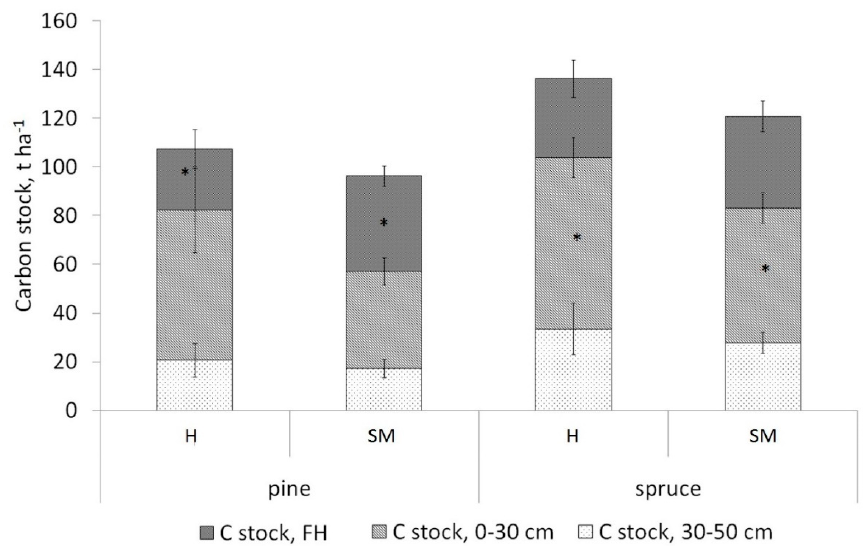
Figure 9. Soil carbon stocks in forests on Carbic Albic Podzols and Albic Retisols with a high proportion of herbaceous plants—H ( n = 12 in pine forests, n = 12 in spruce forests) and with dwarf shrubs and green mosses—SM ( n = 35 in pine forests, n = 15 in spruce forests). The significance of the differences between the mean in category and overall mean was estimated taking into account